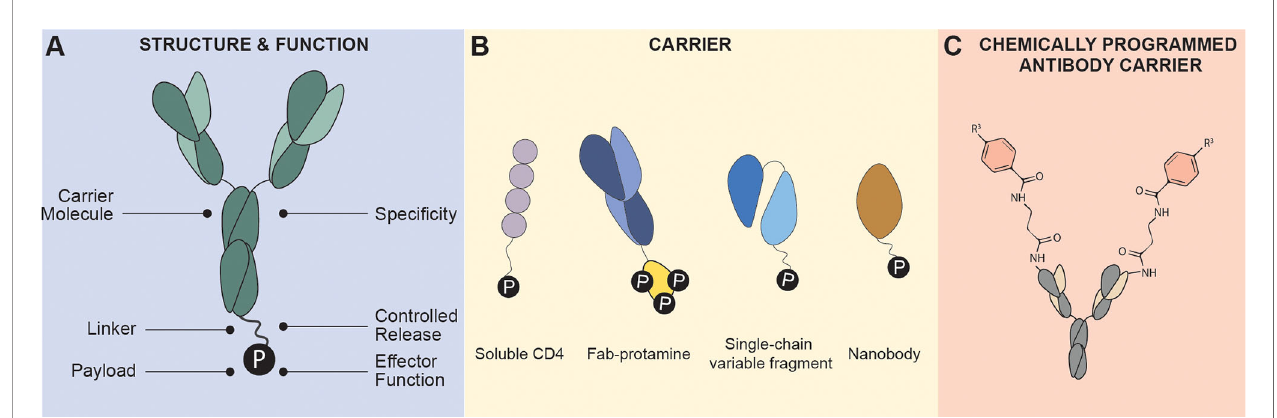
FIGURE 1 | Antibody Conjugate Structure. (A) Antibody conjugates are characterized by a fusion of a carrier molecule speci fi c to an antigen for speci fi city, a linker that connects the carrier and payload providing fl exibility and controlled release of payload, and the effector molecule “ payload ” that can induce cytotoxicity or immune modulation. (B) Carrier molecules are typically monoclonal antibodies (such as IgG1), soluble ligands such as cytokines or receptors), Fab fragment, single- chain variable fragment, and nanobodies. (C) Chemically programmed antibody containing a reactive residue on its binding pocket that can react to derivatives of small molecules. Targeting is conferred by the conjugated small molecules instead of the antibody.